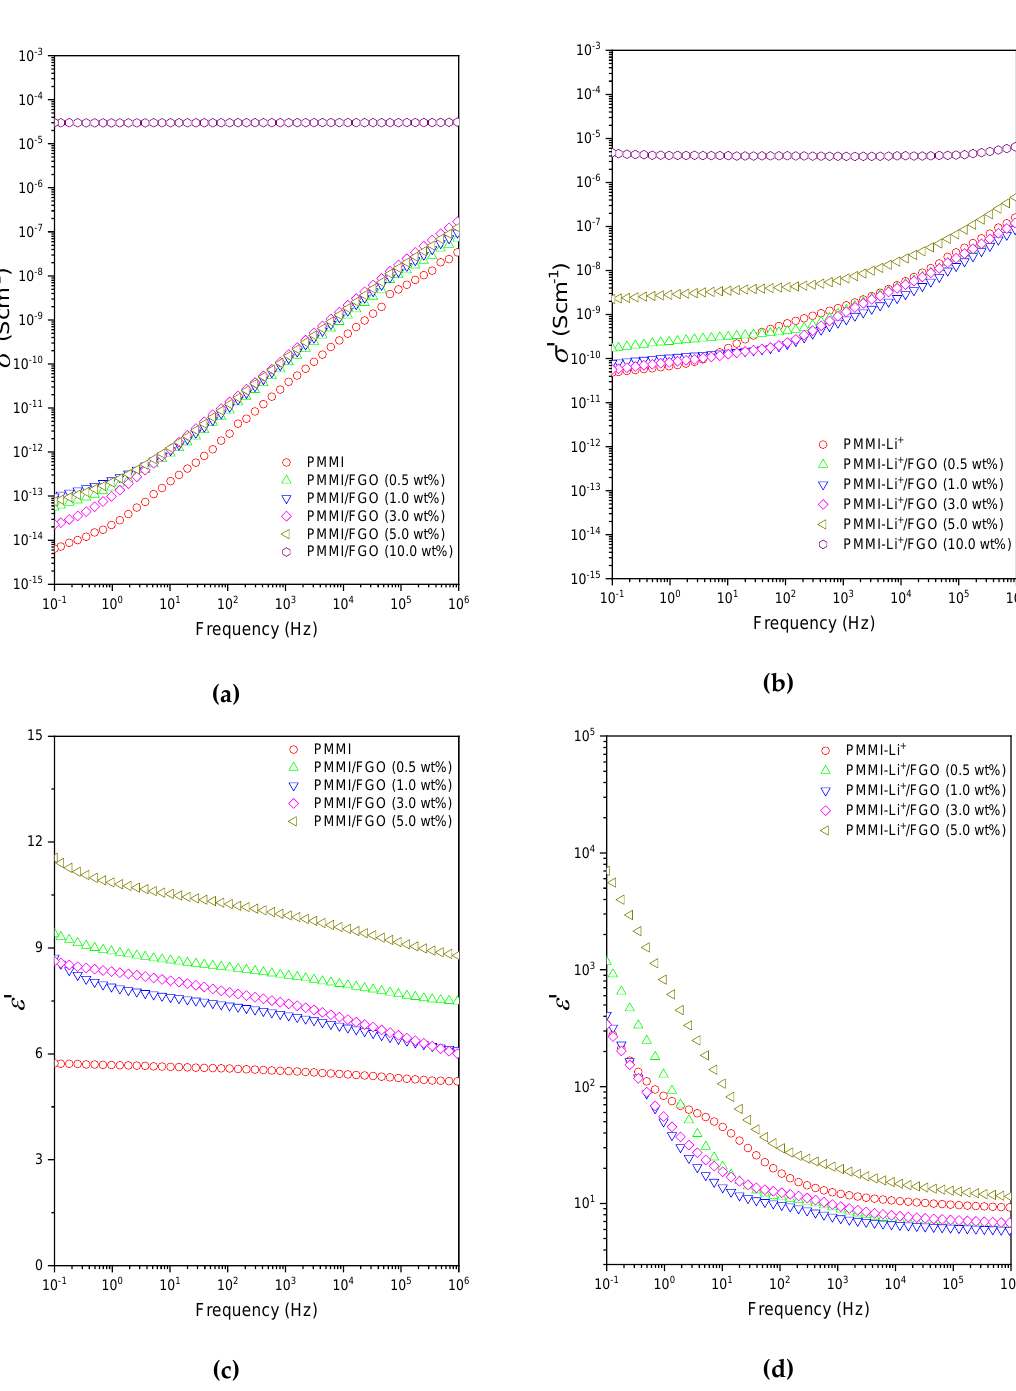
Figure 6. ( a ) Electrical conductivity ( σ (cid:48) ) and ( c ) dielectric permittivity ( ε (cid:48) ) as functions of the frequency for PMMI / FGO. ( b ) Electrical conductivity ( σ (cid:48) ) and ( d ) dielectric permittivity ε (cid:48) as functions of the frequency for PMMI-Li + /FGO.